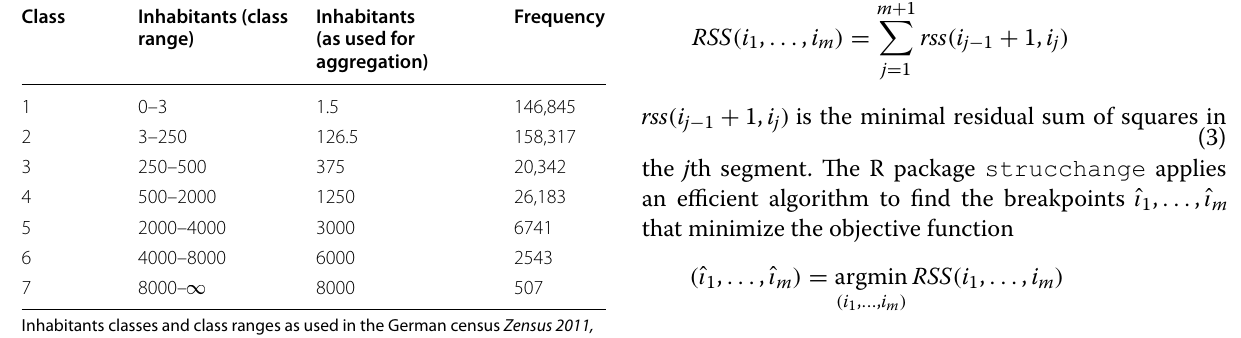
Table 1 Inhabitants classes of the German census